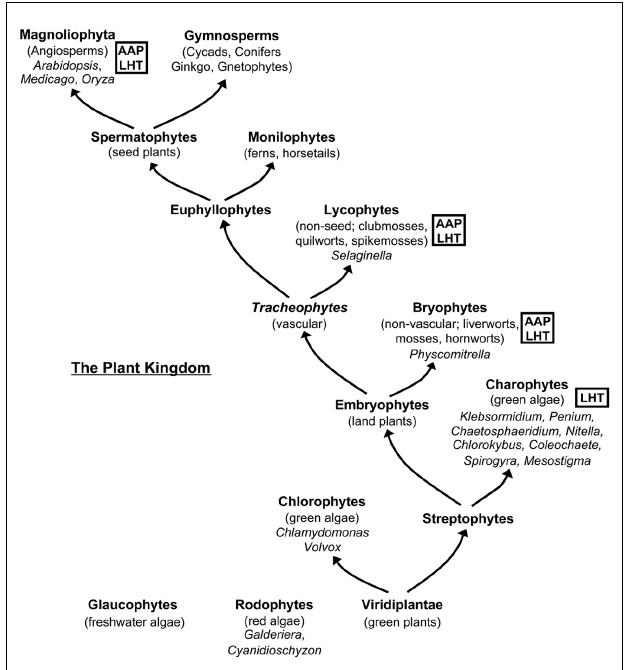
FIGURE 2 | Phylogenetic tree ofAAP and LHT proteins found across taxa. A total of 44 AAP and 39 LHT proteins were identified. AAPs and LHTs form two distinct groups, each sub-divided in clusters or subclusters.The clusters (numbers) and subclusters (letters) were labeled and